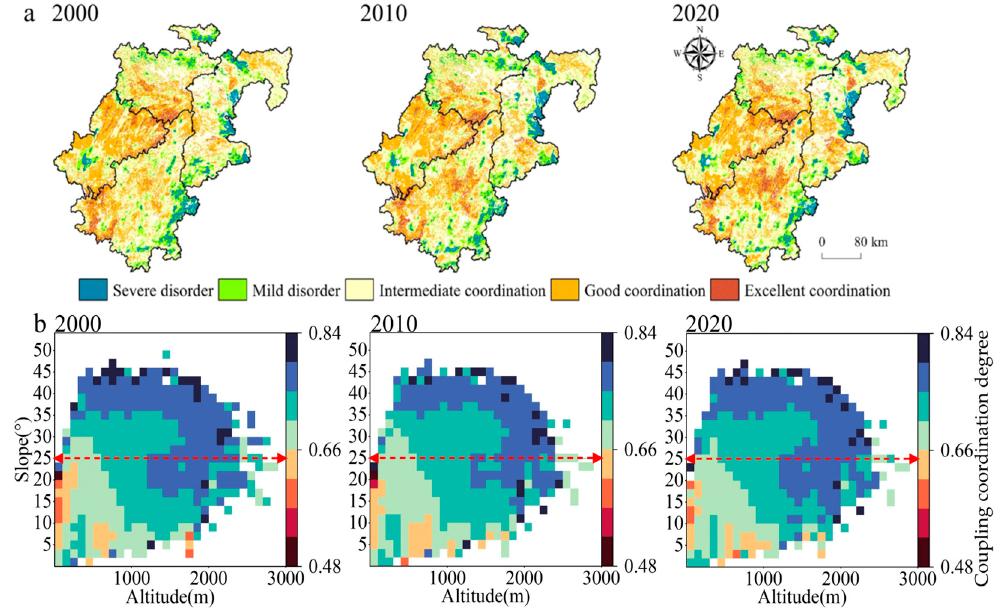
Figure 5. Temporal evolution and spatial distribution of coupling coordination degree values: ( a ) spatial and temporal distribution characteristics; ( b ) topographic gradient characteristics: above the red dashed line arrow in the figure are the distribution characteristics of CCCD of sloping cropland suitable for reforestation, while the below are the distribution characteristics of CCCD of cropland with good production potential.